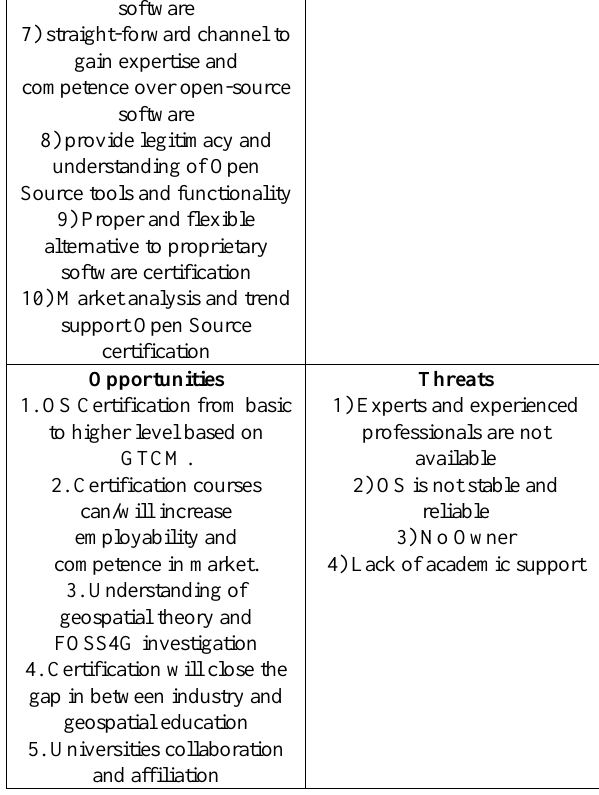
Table 4: SWOT analysis of the certification business